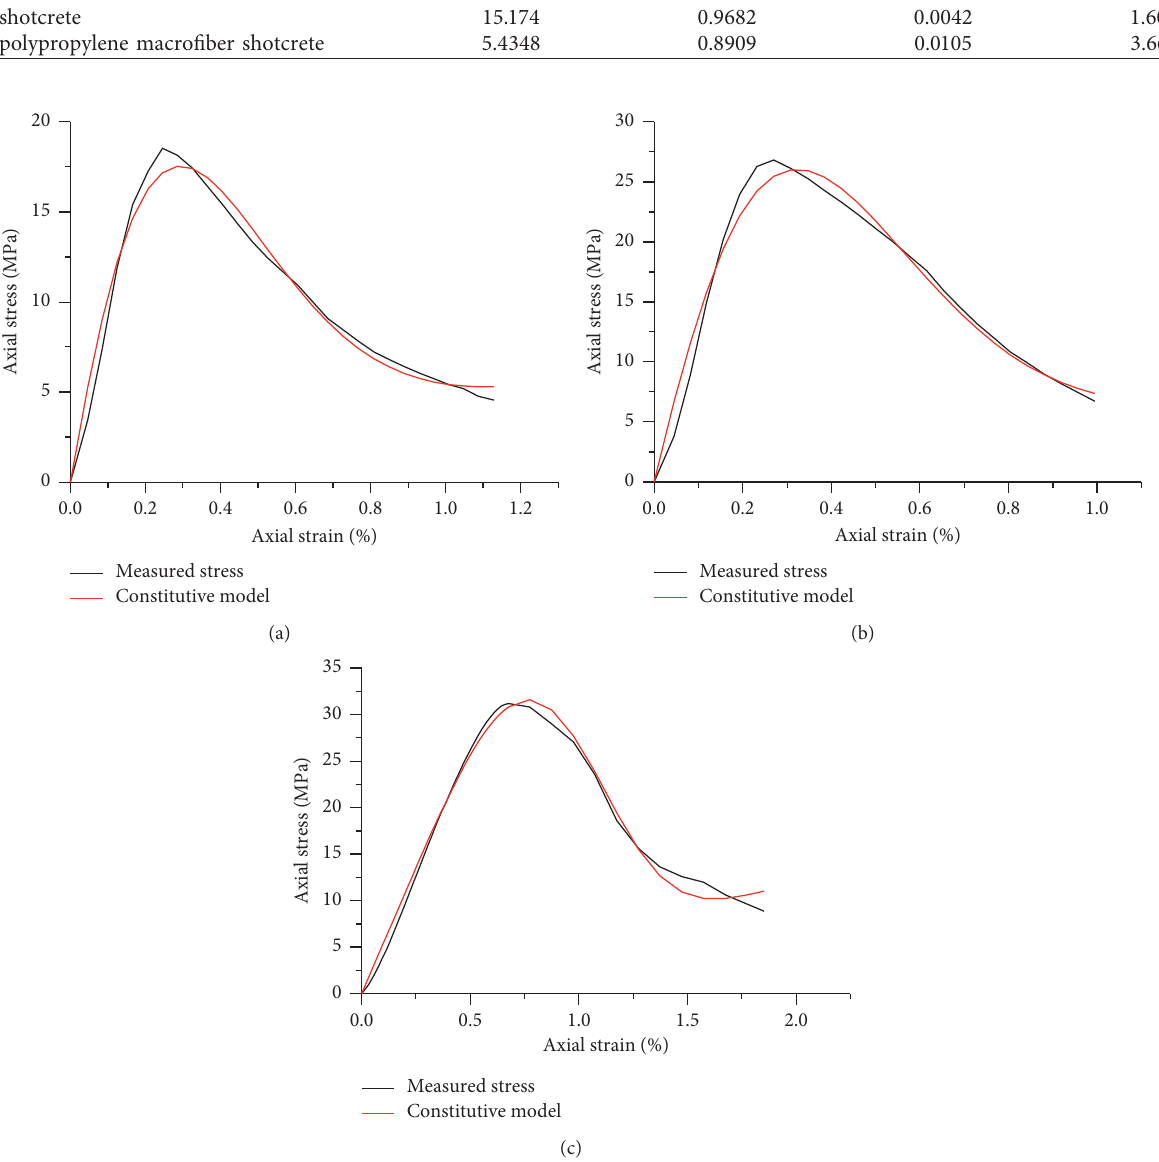
Figure 8: Comparison between experimental data and theoretical models. (a) Comparison of experimental data and theoretical model for dry shotcrete. (b) Comparison of experimental data and theoretical model for wet shotcrete. (c) Experimental data for